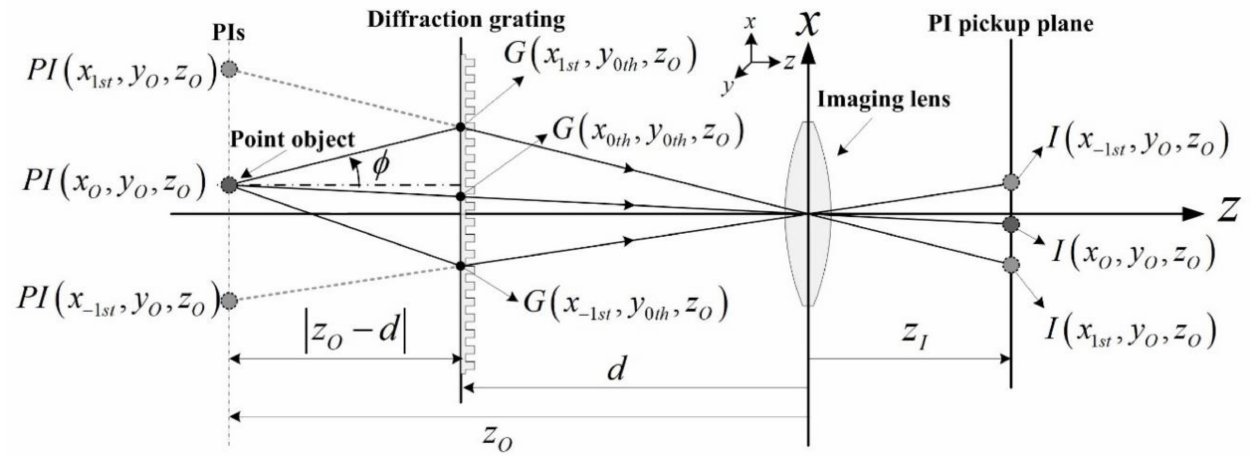
Figure 3. Geometries for the parallax angles of PIs in diffraction grating